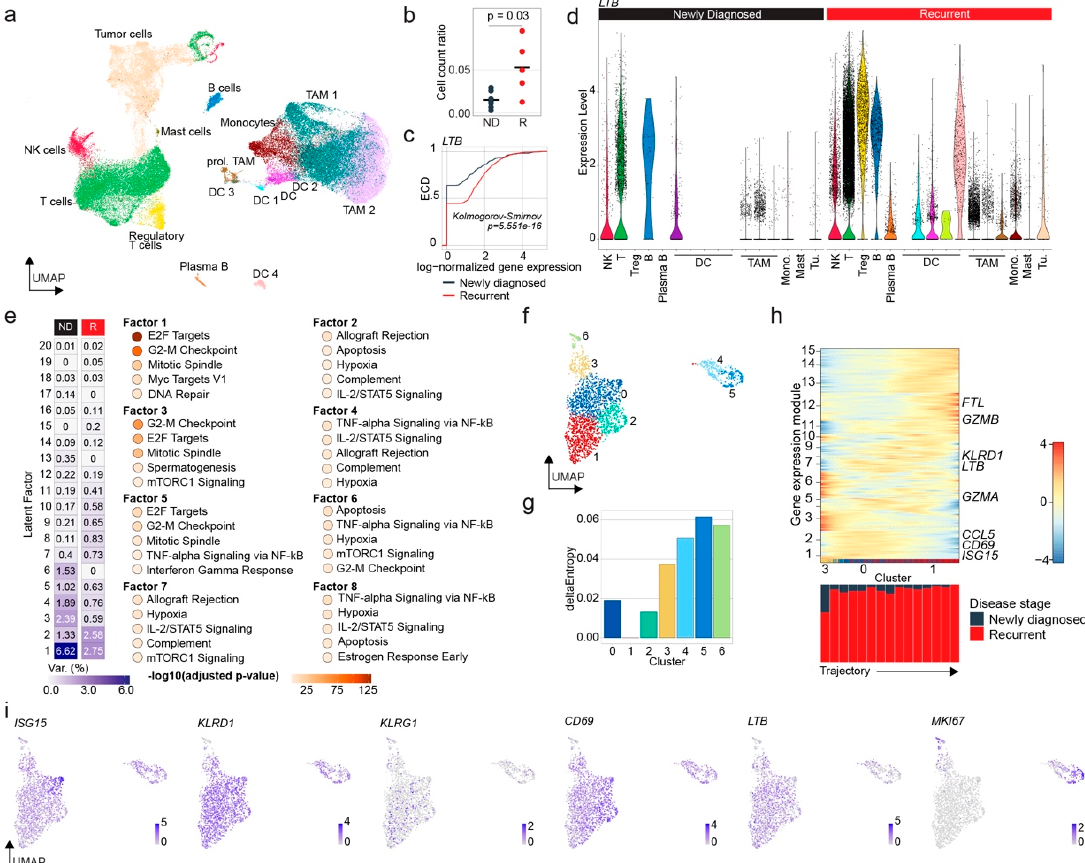
Figure 4. Dysfunctional NK cells accumulate in recurrent human glioblastoma. ( a ) UMAP of 61,164 human glioblastoma-associated cells from the Antunes et al. dataset. The color coding shows immune cell assignment as provided by the authors of the study [20]. The tumor cells were assigned based on the expression of glioblastoma-associated gene signatures. Non-neoplastic oligodendrocytes and immune cells that were not assigned by the authors were excluded. ( b ) Dot plot visualization of the NK cell count relative to all immune cells color-coded by the tumor stage. The indicated p -value was calculated using an unpaired two-sided Wilcoxon rank-sum test. ( c ) Empirical cumulative density function plot of the LTB expression in NK cells color-coded by the tumor stage. The indicated p -value was calculated using a two-sided two-sample Kolmogorov–Smirnov test. ( d ) Dot violin plots showing LTB expression in the respective cell types in ND and R glioblastomas from figure panel a. ( e ) Heatmap visualization of latent factors determined by MOFA+ analysis. The color scale indicates the percentage of variance explained. For enhanced readability, the respective values are indicated in each cell. The enrichR-based pathway enrichment analysis of MSigDB Hallmark 2020 pathways. The color of the dots indicates the -log10-transformed adjusted p -values of the enrichment. ( f ) UMAP visualization of 2,158 cells sub-clustered from the NK cell cluster of figure panel a. The color coding of the top panel corresponds to the new cluster assignment. The bottom panel is color-coded by the p.i. time point. ( g ) Bar plot showing the transcriptional entropy differences across the cluster. Cluster 1, with the lowest entropy, is set to 0. The color coding is consistent with that of figure panel f. ( h ) Heatmap of the locally smoothed gene expression z-scores along the trajectory between Clusters 3, 0 and 1. Genes with a correlation coefficient above 9 are summarized into gene expression modules; gene expression modules with at least 3 genes are shown. The bar plot below the heatmap indicates the tumor stage composition of each step along the trajectory. ( i ) UMAP visualization of cells from figure panel f color-coded by the expression of the indicated genes.